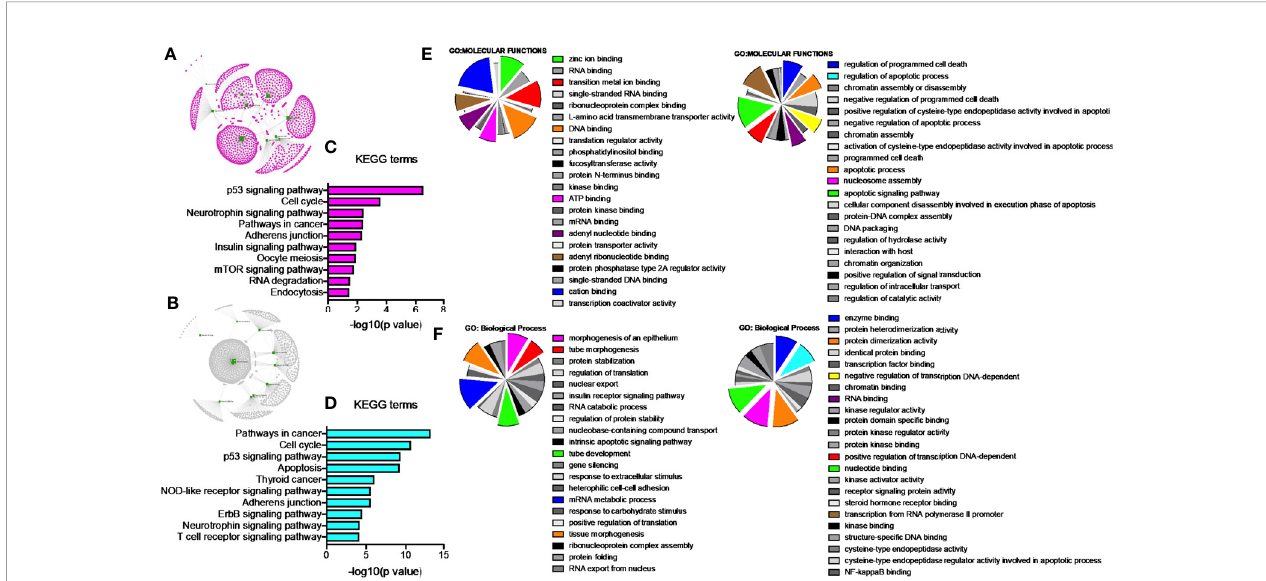
FIGURE 2 | Network analysis identi fi es mRNA target genes involved in altered pathways following AG-205 treatment. (A) The top ten upregulated miRNAs depicted in green, identify target genes highlighted in pink. (B) The top ten downregulated miRNAs are also depicted in green with their respective target genes highlighted in grey. (C) and (D) KEGG pathway analysis identi fi ed the top 10 signi fi cantly enriched pathways (non-disease related) involved within the miRNA network hub, adjusted p < 0.05. (E, F) . GO: term Molecular functions and Biological process involved within the observed